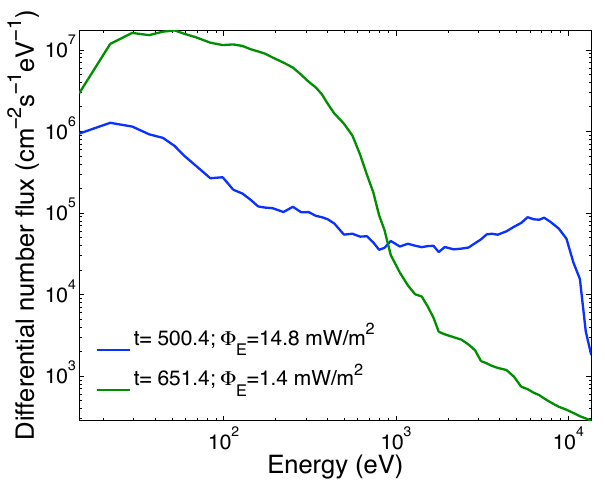
Fig. 7. Data input for modelling of precipitation-driven heating ef- fects: input spectra from SIERRA at two times; 0 ◦ pitch angle data from the electron detector, calculated as differential number flux, at T+500s and